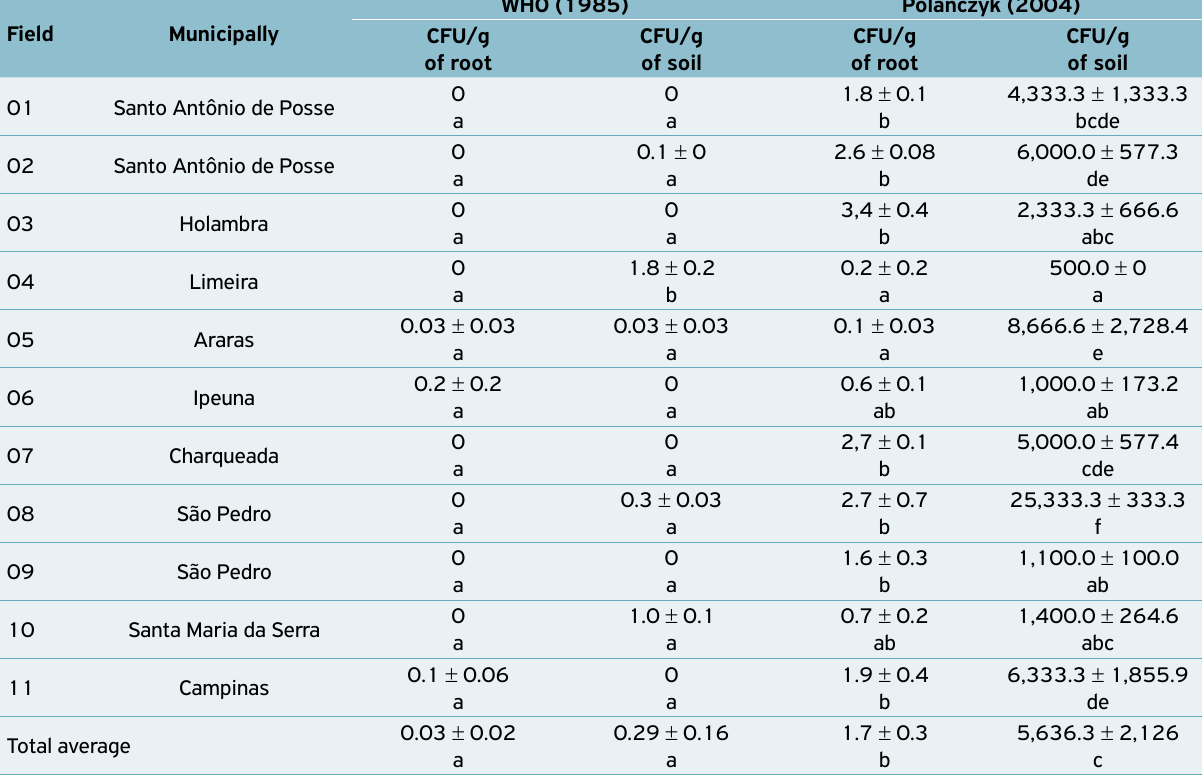
Table 2. Colony counts of Bacillus (× 10 2 ) per gram of sugarcane root and of its associated soil, obtained from 11 fields of sugarcane, in nine municipalities of São Paulo state, isolated using two different methods.